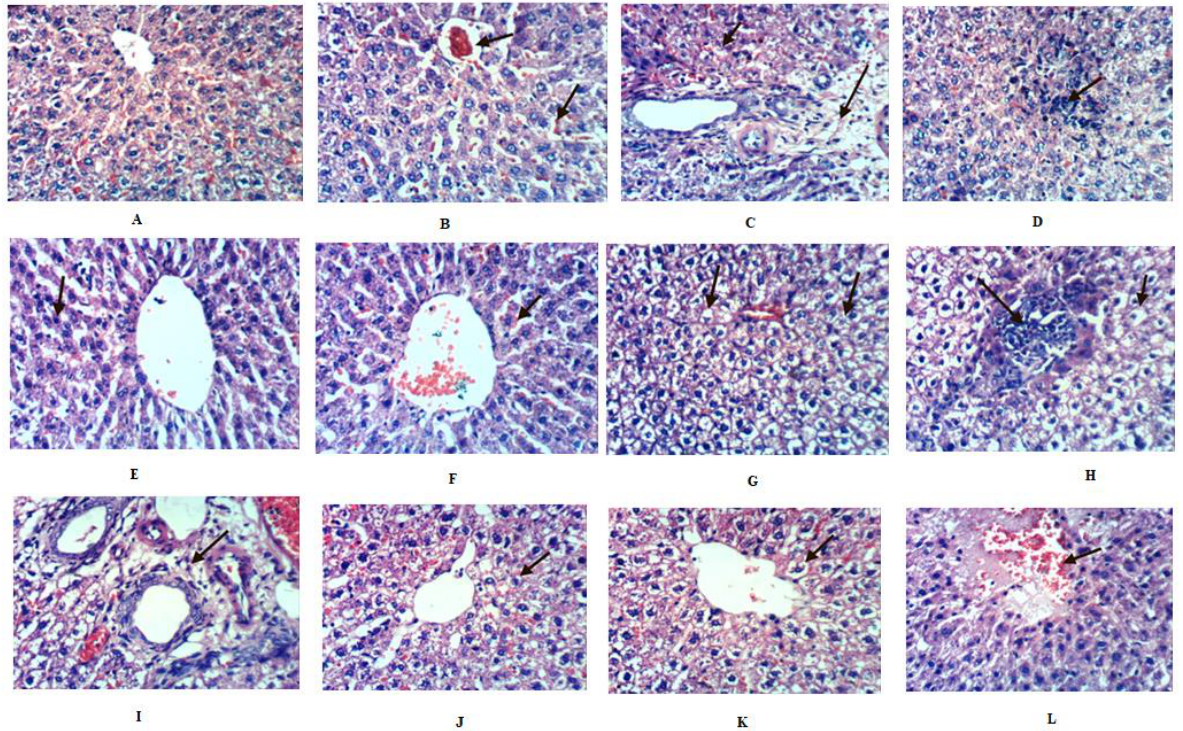
Figure 3. Histopathological results of the activity for Premna odorata extracts (crude, defatted, and n-hexane) and silymarin in alcohol-inflamed liver female Wistar albino rats using a dose of 500 and 200 mg / kg b.w., respectively (H and E X 400). ( A ) The liver of a rat from group 1 (negative control) showing the negative histological structure of a hepatic lobule. ( B ) The liver of a rat from group 2 (positive control) showing congestion of the central vein and hepatic sinusoids. ( C ) The liver of a rat from group 2 showing cytoplasmic vacuolization of hepatocytes and a portal edema. ( D ) The liver of a rat from group 2 showing focal hepatic necrosis associated with inflammatory cell infiltration. ( E ) The liver of a rat from group 3 (crude extract-treated group) showing necrosis of sporadic hepatocytes. ( F ) The liver of a rat from group 3 showing slight congestion of hepatic sinusoids. ( G ) The liver of a rat from group 4 (defatted extract-treated group) showing slightly hydropic degeneration of hepatocytes. ( H ) The liver of a rat from group 4 showing hydropic degeneration of hepatocytes and focal hepatic necrosis associated with inflammatory cell infiltration. ( I ) The liver of a rat from group 5 (n-hexane-treated group) showing a slightly portal edema. ( J ) The liver of a rat from group 5 showing slightly hydropic degeneration of hepatocytes. ( K ) The liver of a rat from group 6 (silymarin-treated group) showing slightly hydropic degeneration of hepatocytes. ( L ) The liver of a rat from group 6 showing slightly focal hepatic